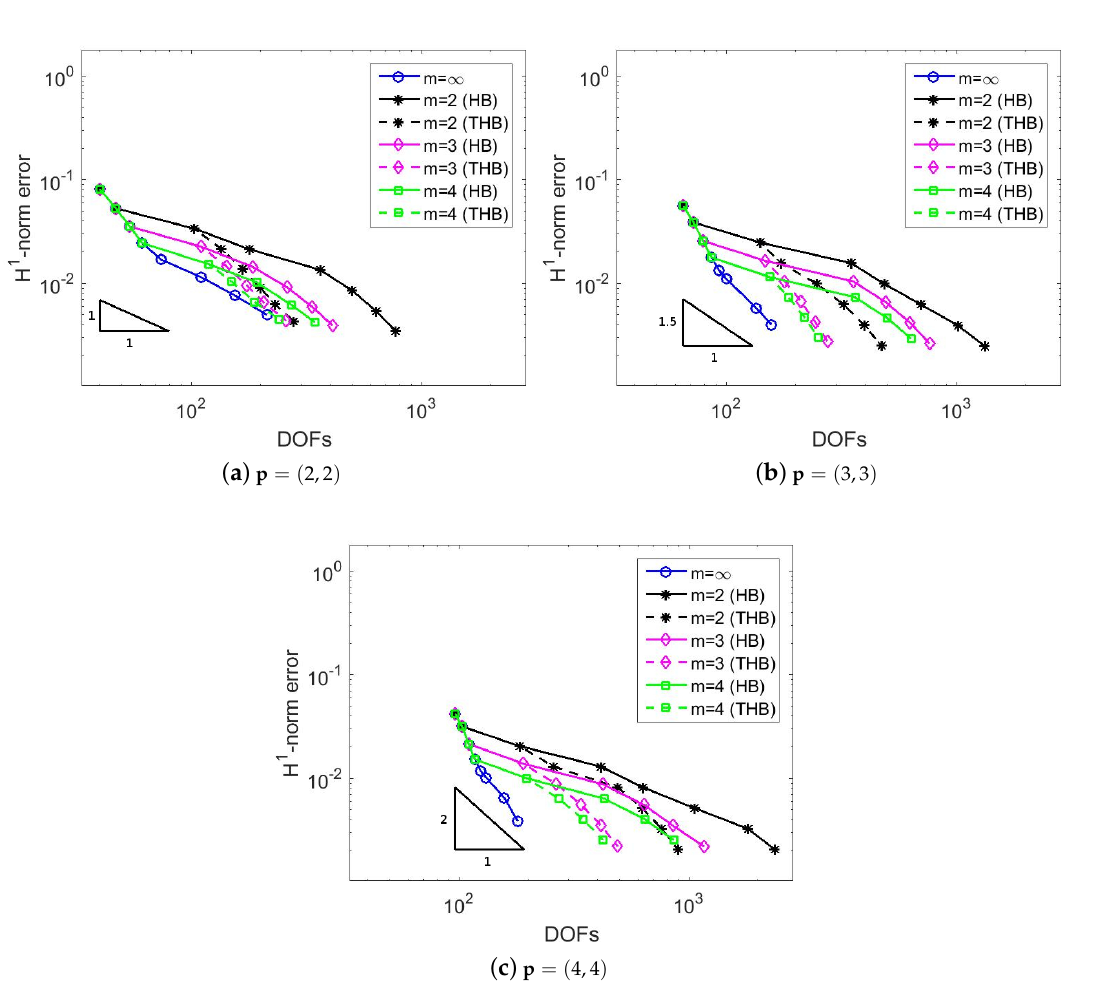
Figure 12. Comparison of the convergence of the H 1 -norm error versus degrees of freedom (DOFs) for H -admissible (HB) and T -admissible (THB) meshes, with p = ( 2,2 ) , ( 3,3 ) , ( 4,4 ) (from top to bottom